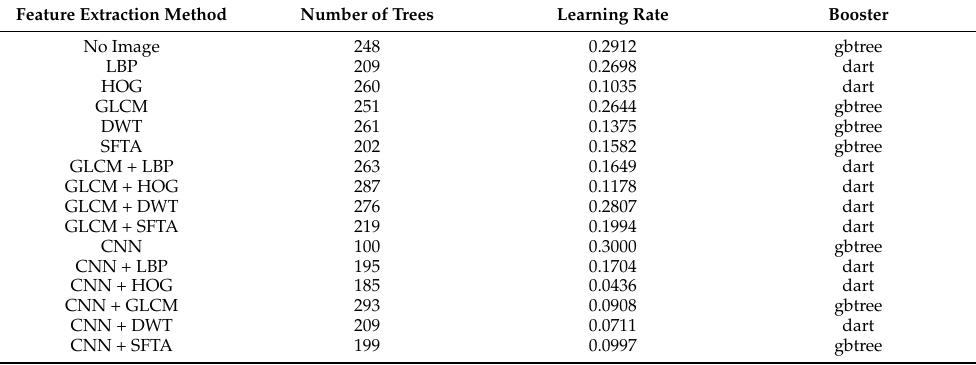
Table 2. Hyper-parameters of XGBoost for combinations of numeric features and features from one or two feature extraction